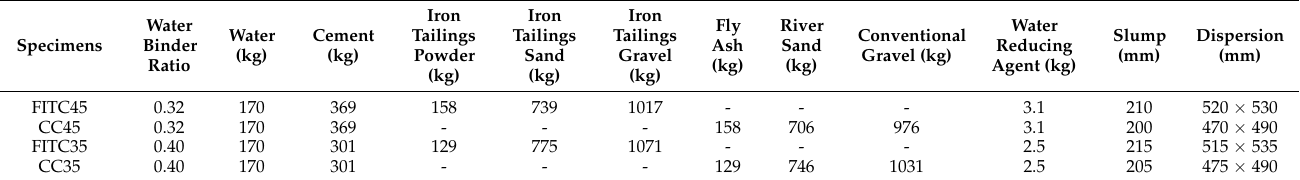
Table 5. Design of mix proportions.